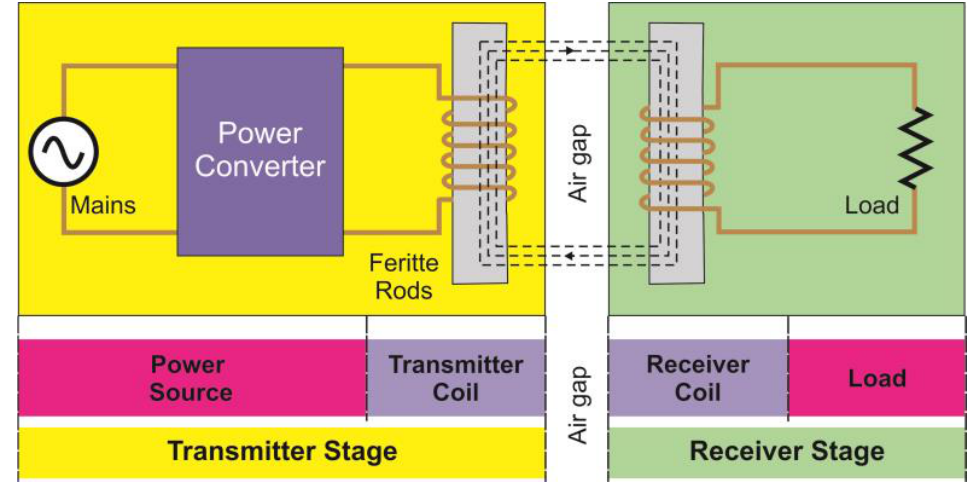
Figure 2. Schematic of IPT system.